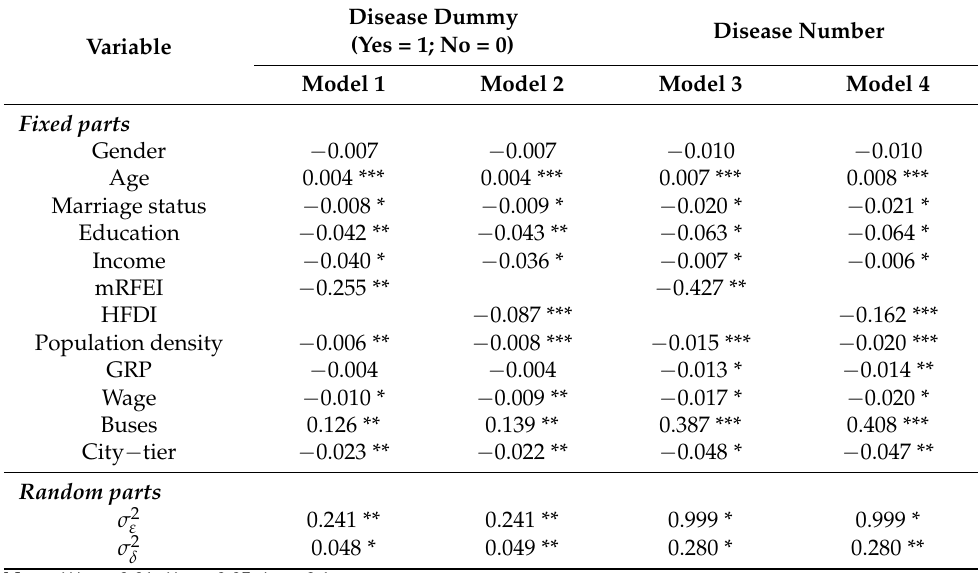
Table 3. Results of the baseline multilevel